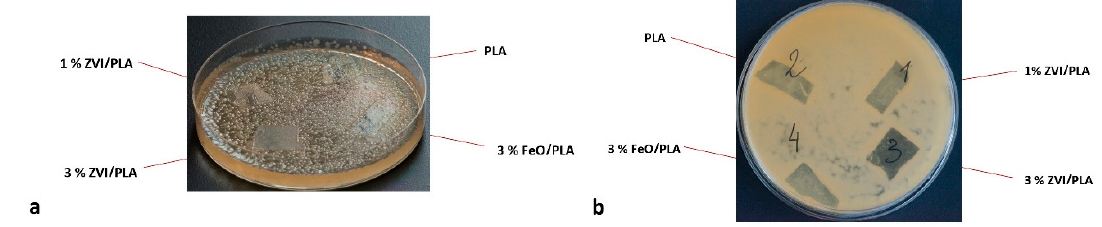
Figure 3. Gloss level of LCA films measured at the angle of 60 degrees for pure polylactide film and with the addition of zero-valent iron in different concentrations.